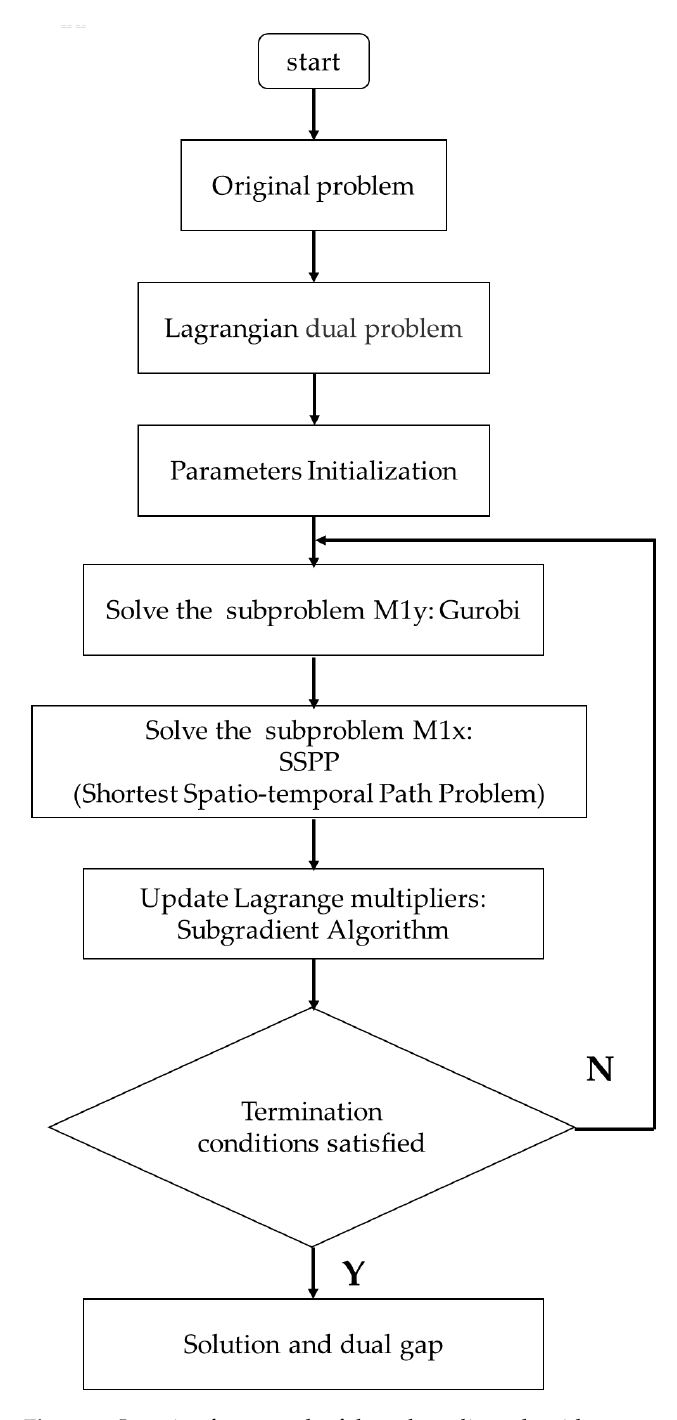
Figure 2. Iterative framework of the subgradient algorithm. The Lagrangian multiplier updating rule is illustrated in Formula